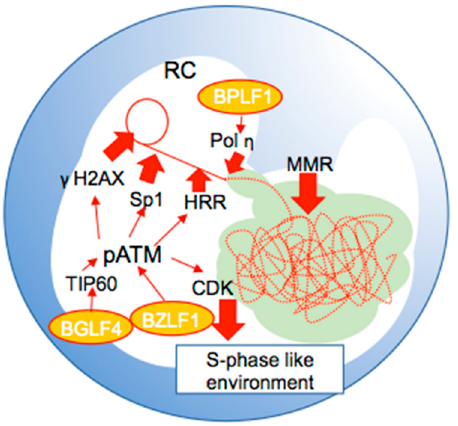
Figure 3. Model of the interactions among DNA damage response factors which enhance EBV DNA synthesis and viral proteins at RCs. The central kinase of the DDR, ATM, is activated by BGLF4 and BZLF1. Phosphorylated ATM (pATM) activates H2AX ( γ H2AX), S-phase cyclin-dependent kinases (CDKs), Sp1, and homologous recombinational repair (HRR) enhance viral DNA synthesis. BPLF1 recruits pol η onto newly synthesized viral DNA to mature. Mismatch repair (MMR) factors are also involved in the maturation of viral DNA stored at the BMRF1-core.